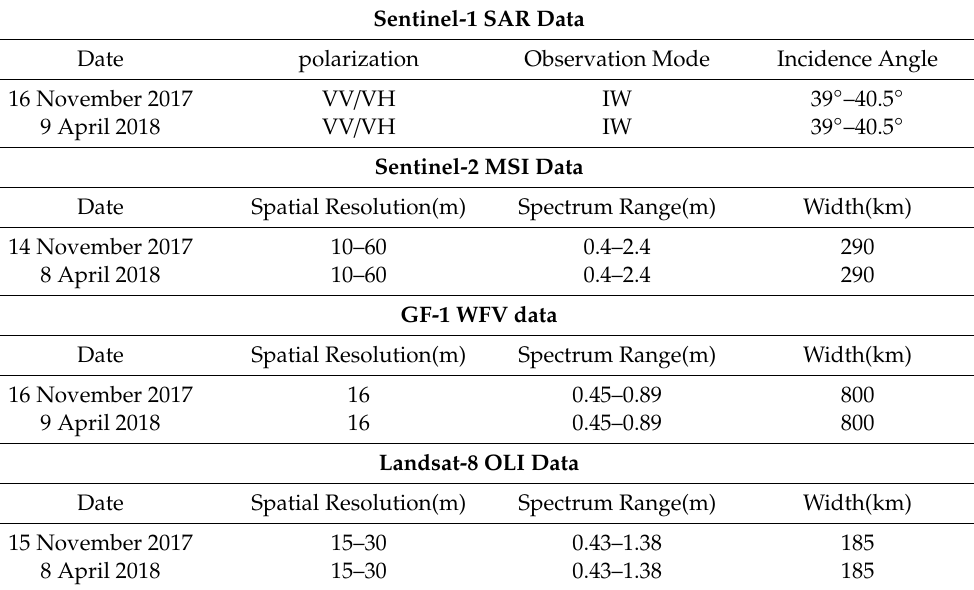
Table 2. Sentinel-1 and optical data used in this